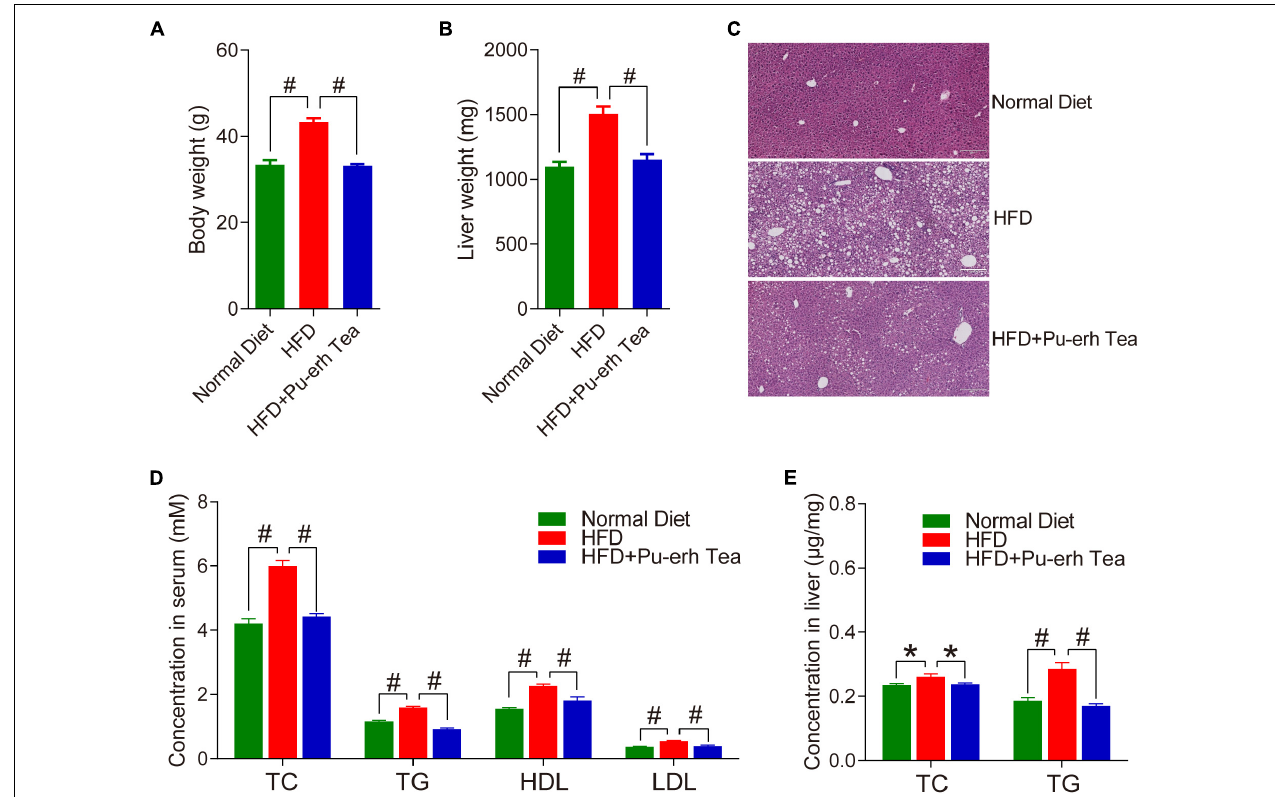
FIGURE 1 | Pu-erh tea significantly reduced HFD-induced increase in body weight and lipids in serum and liver of C57BL/6 mice. (A) Body weight of mice fed with control diet, HFD, and HFD with 450 mg/Kg/day of Pu-erh tea across 22 weeks of intervention. (B) Liver weight of mice fed with control diet, HFD, and HFD with 450 mg/Kg/day of Pu-erh tea for 22 weeks. (C) HE staining of liver section of mice fed with control diet, HFD, and HFD with 450 mg/Kg/day of Pu-erh tea for 22 weeks. (D) Concentrations of TC, TG, HDL, and LDL in serum of mice fed with control diet, HFD, and HFD with 450 mg/Kg/day of Pu-erh tea for 22 weeks. (E) Concentration of TC and TG in liver of mice fed with control diet, HFD, and HFD with 450 mg/Kg/day of Pu-erh tea for 22 weeks. Data were expressed as mean ± SEM and differences were assessed by Mann–Whitney U test, ∗ p < 0.05, # p <